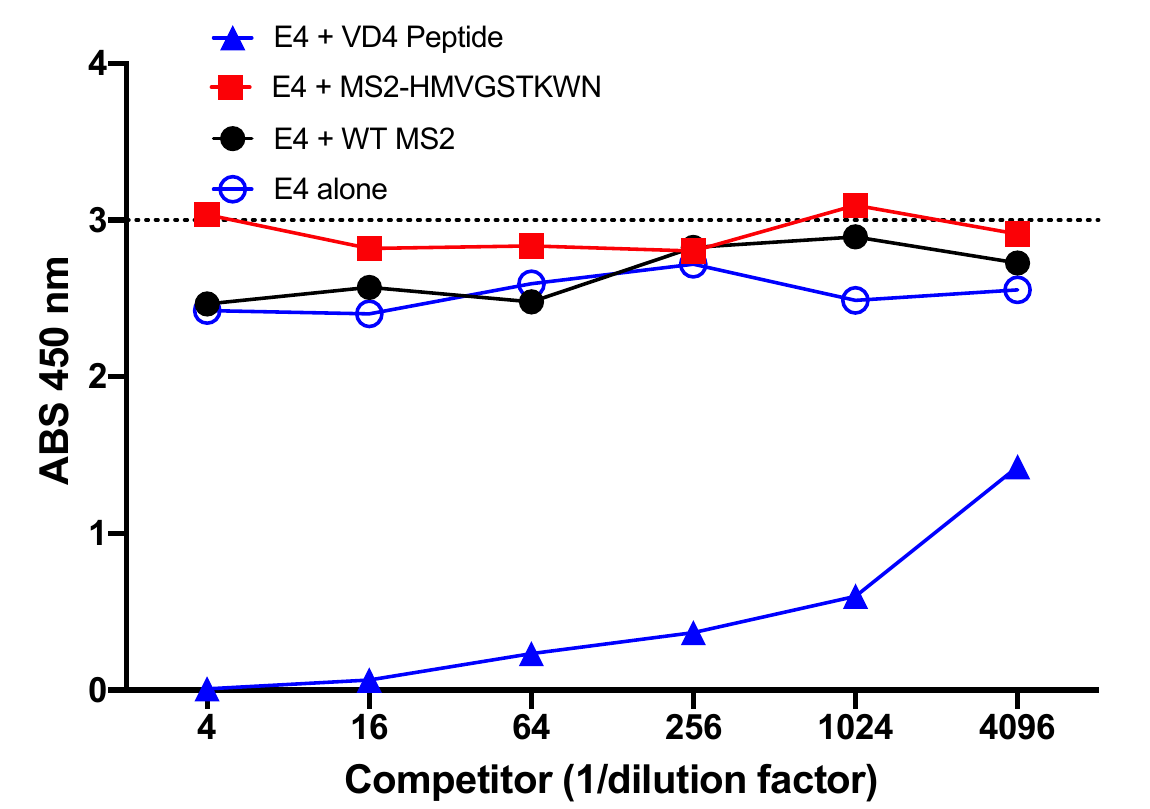
Figure 4. Preferential binding of E4 mAb. Competition peptide ELISA revealed that addition of MS2-HMVGSTKWN as a binding competitor of E4 mAb did not change the binding potential to the VD4 peptide, whereas addition of the linear VD4 peptide reduced binding of the E4 mAb to the bait VD4 peptide.